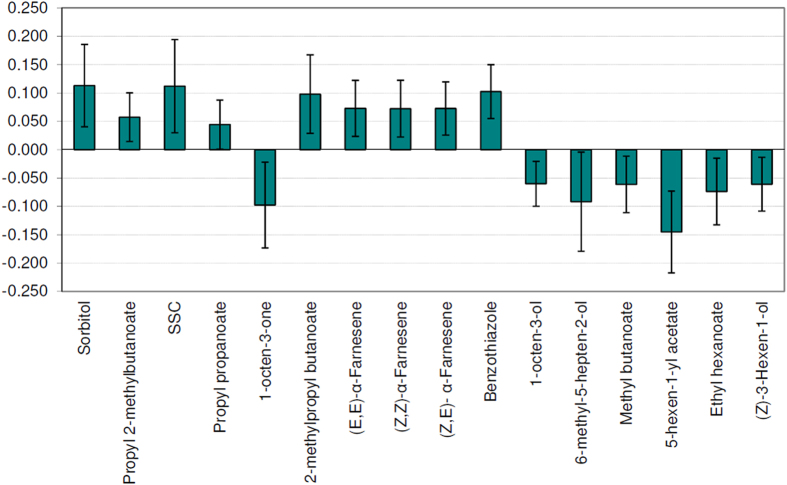
Significant regression coefficients with jack knifing intervals from the OPLS regression model for sweetness listed in order of variable importance in projection (VIPs) >0.95.